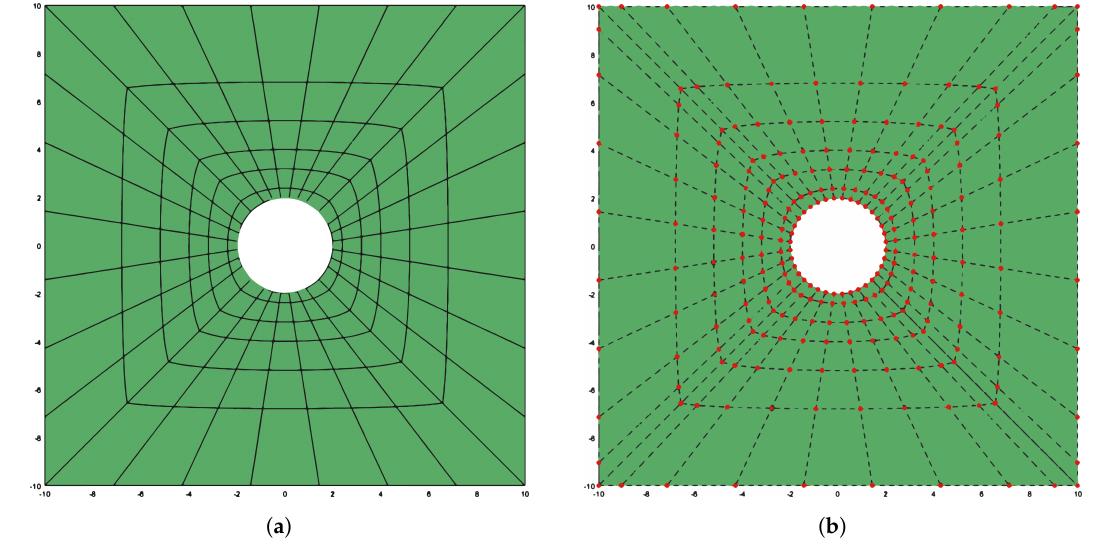
Figure 7. Case 1: physical domain, h 2 -refinement mesh and correspondent control points. ( a ) The physical mesh; ( b ) the control point for the NURBS surface.